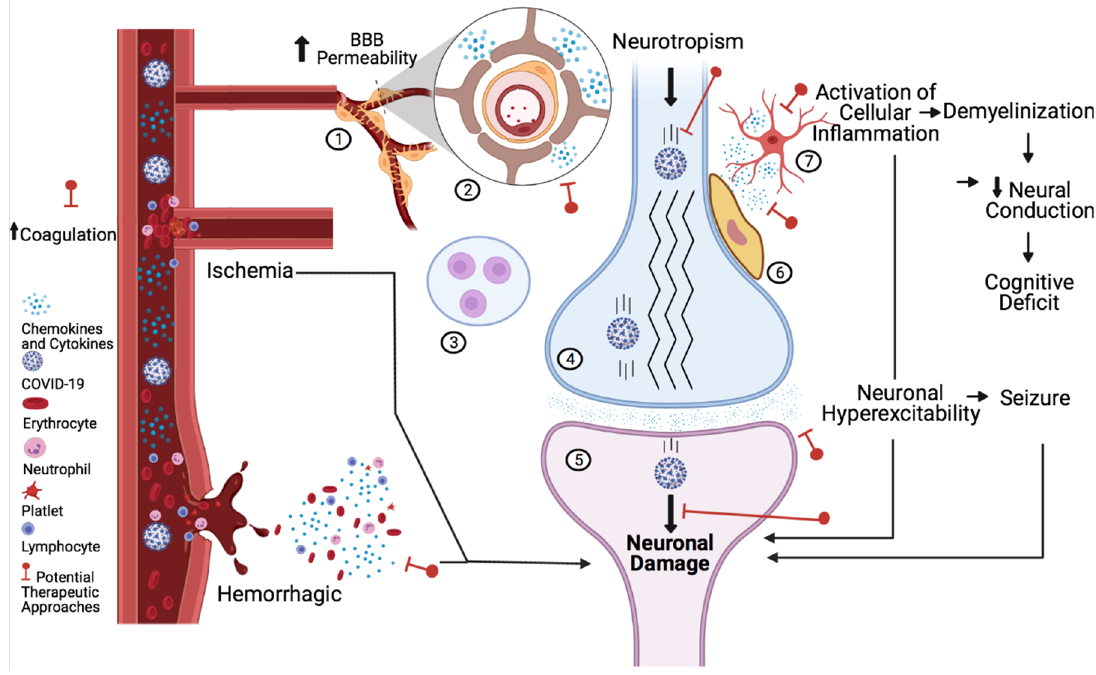
Figure 1. COVID-19 in the vascular system and neural tissue: (1): vessel; (2): BBB (blood–brain barrier); (3): circumventricular organs; (4): presynaptic terminal; (5): post synaptic terminal; (6): microglia; (7): astrocyte.